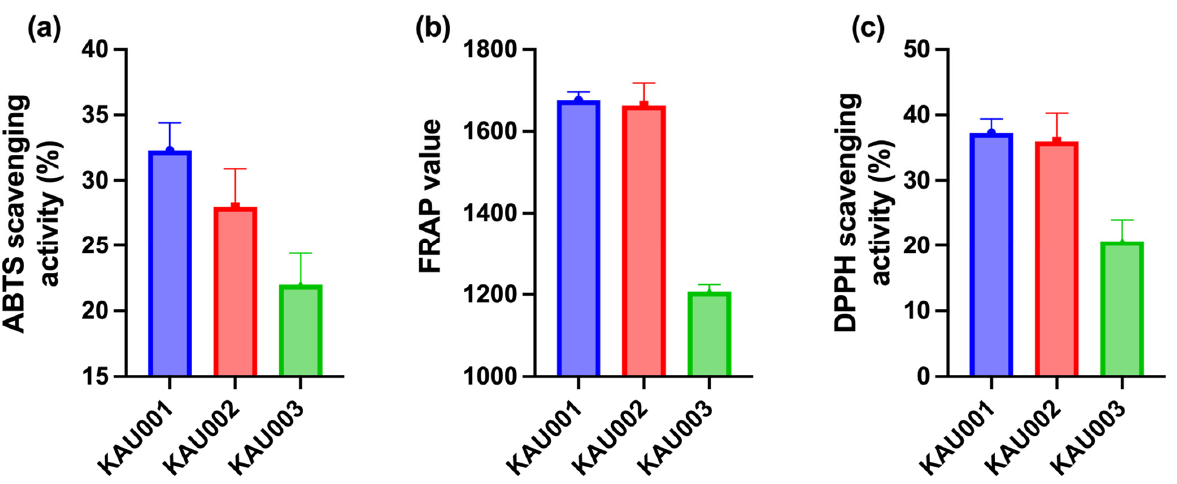
Figure 4. Antioxidant effect of LAB isolated. ( a ) ABTS scavenging activity assay. ( b ) FRAP assay. ( c ) DPPH scavenging activity assay. Data are expressed as mean ± S.D. from three independent experiments.